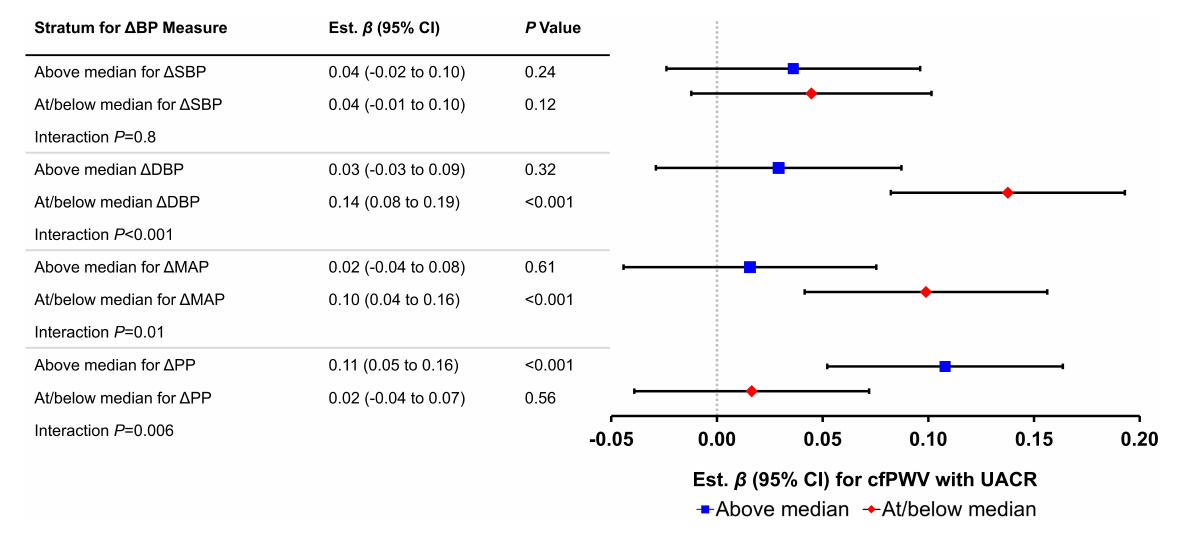
FIGURE2 Relations of carotid-femoral pulse wave velocity (cfPWV) with urinary albumin-creatinine ratio (UACR) by median postural change in blood pressure measures ( N = 3,488). Effect sizes ( β s) and 95% confidence intervals are from linear regression models; Bonferroni-adjusted P -values ( P = 0.05/8 = 0.00625) were used to assess significance of associations. Each vascular measure is considered separately in the models. Estimates represent difference in natural log-transformed UACR (in standard deviation units) per 1 standard deviation unit increase in the negative inverse of cfPWV. (cid:49) SBP, postural change in systolic blood pressure; (cid:49) DBP, postural change in diastolic blood pressure; (cid:49) MAP, postural change in mean arterial pressure; (cid:49) PP, postural change in pulse pressure. All models adjusted for age, sex, corresponding supine blood pressure, body mass index, heart rate, total/high-density lipoprotein cholesterol ratio, alcohol consumption (past year), prevalent cardiovascular disease, current smoker, triglycerides, and prevalent